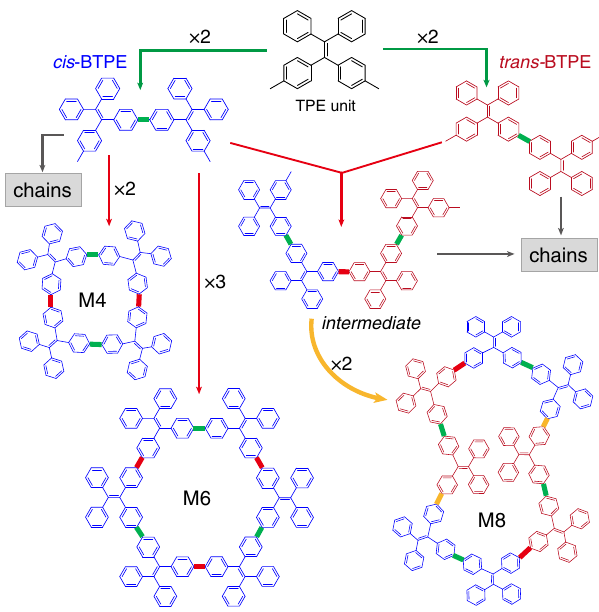
Fig. 5 Proposed reaction pathways. Multi-step reaction pathways for forming M4, M6, and M8